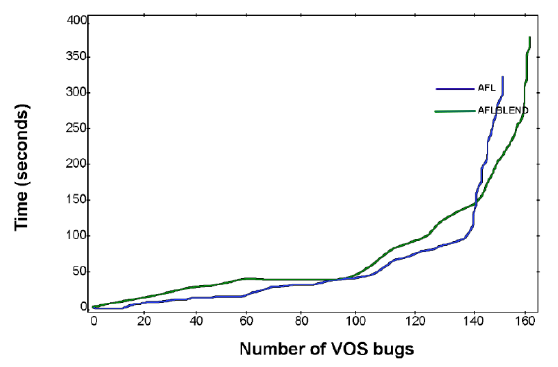
Fig. 5: Results for value overrun susceptibilities